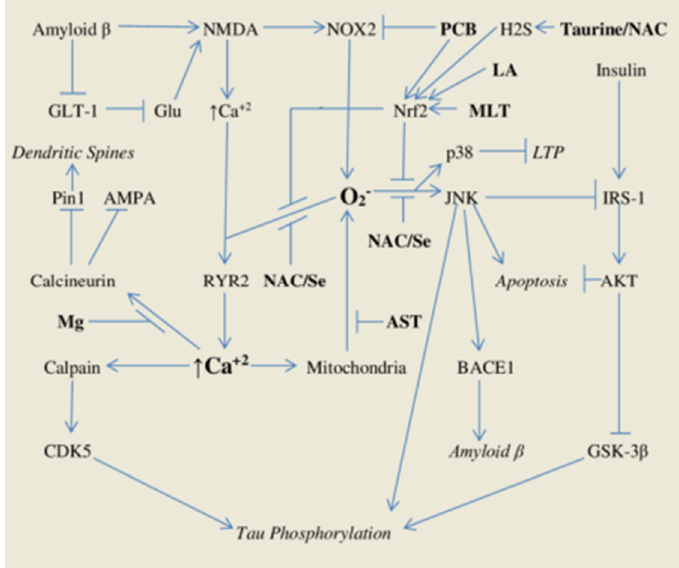
Figure 1. Intracellular calcium signals and oxidant production, triggered by amyloid β via N-methyl-D-aspartate (NMDA) receptors, collaborate to promote neuronal tau hyperphosphorylation, block formation of dendritic spines, promote amyloid β formation, suppress long term potentiation (LTP), and induce apoptosis. Antioxidant nutraceuticals with potential for intervening in this process are highlighted in bold.